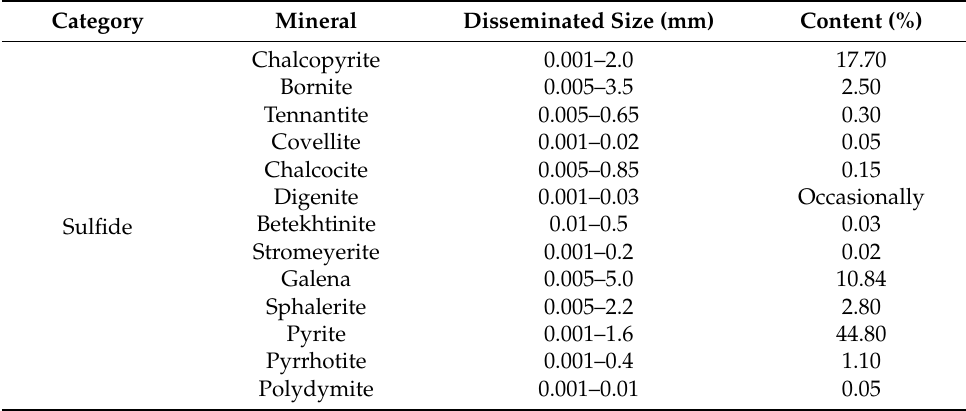
Table 1. Mineral composition and disseminated particle